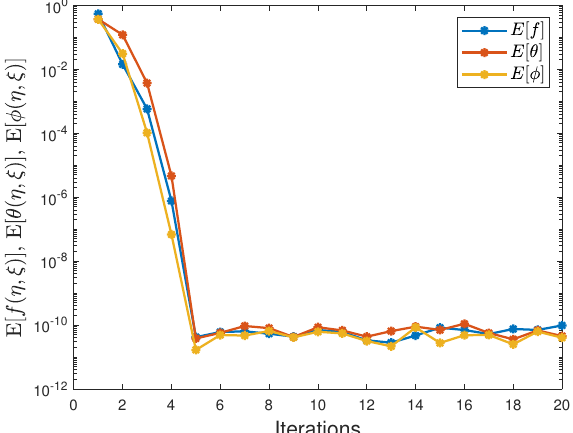
Figure 2. Convergence graphs of f ( η , ξ ) , θ ( η , ξ ) , and φ ( η , ξ ) .